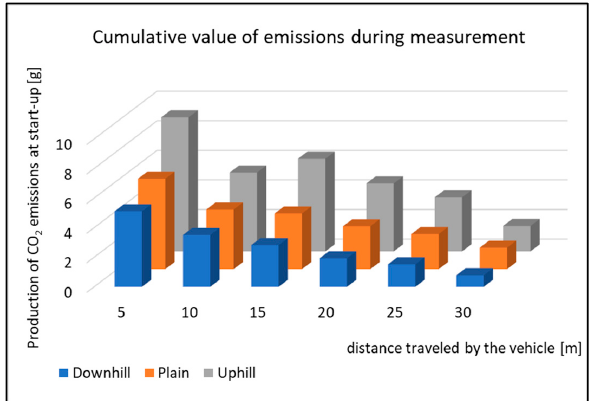
Figure 14. Cumulative value of emissions CO 2 during measurement.